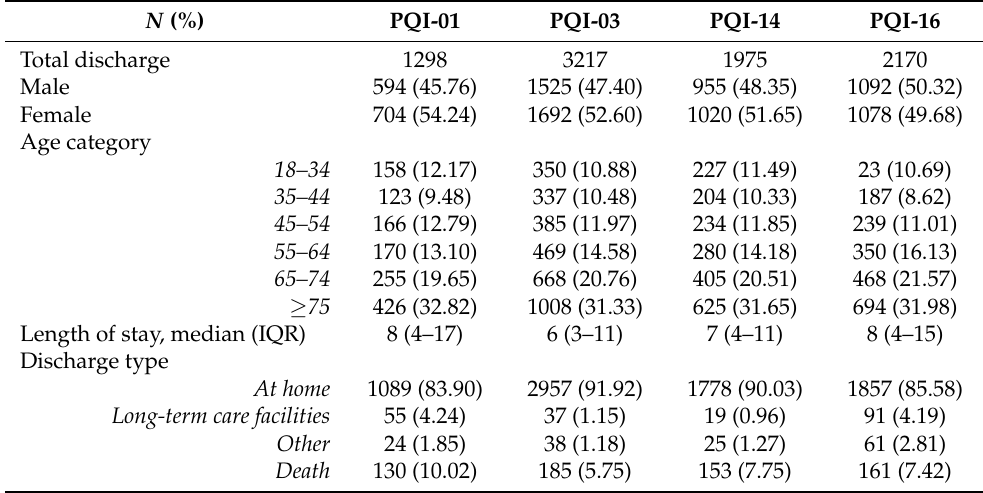
Table 1. Characteristics of included